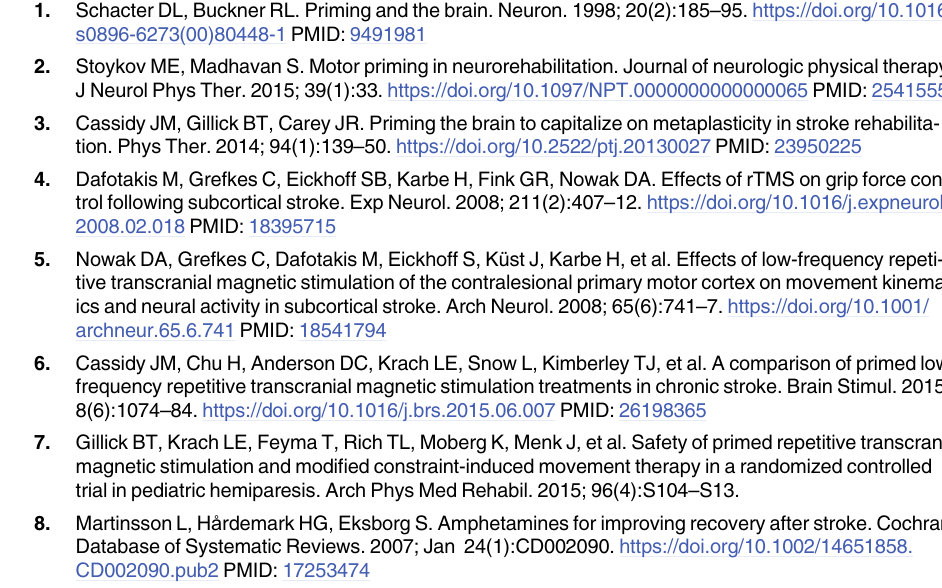
S4 Table. High beta (20–30 Hz)